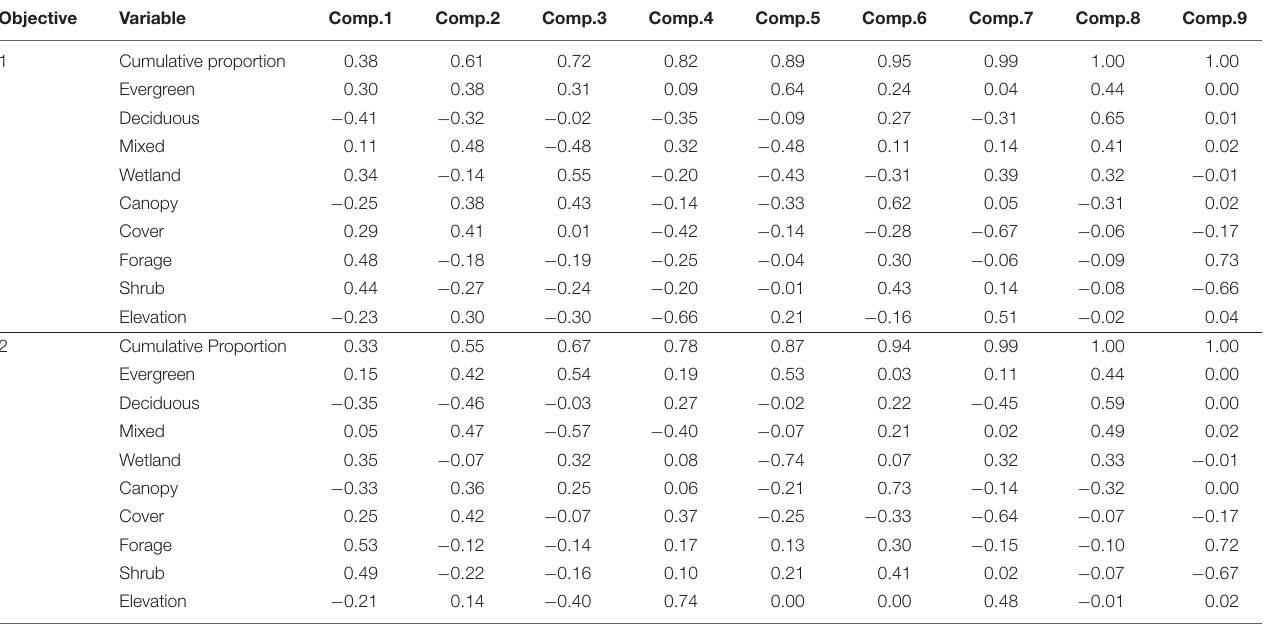
TABLE 3 | A Principal Component Analysis of variables considered when analyzing multi-season occupancy data for moose ( Alces alces ) in northeastern Vermont, United States. Objective Variable Comp.1 Comp.2 Comp.3